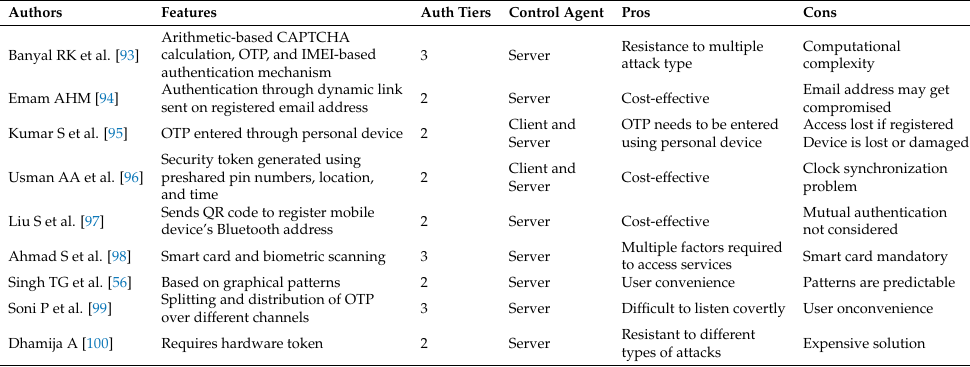
Table 3. Comparison of authentication